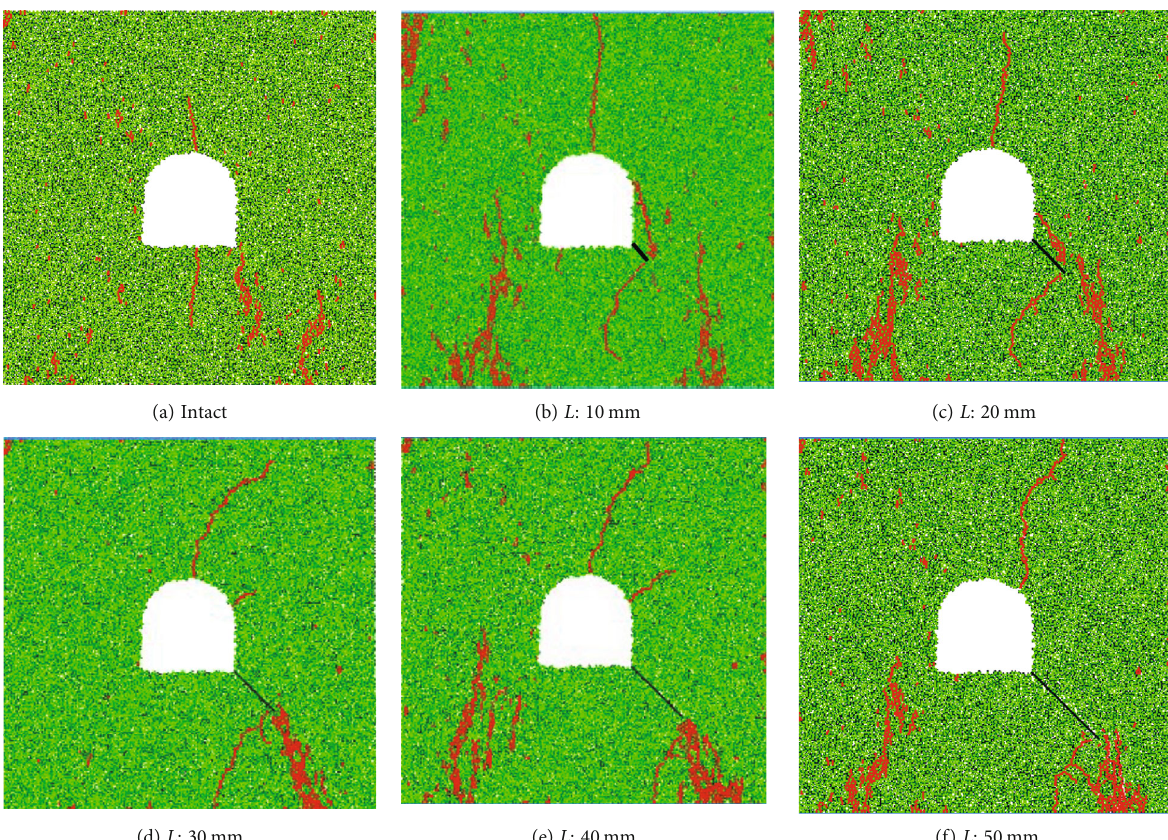
Figure 11: Failure modes of the tunnel with di ff erent joint lengths.